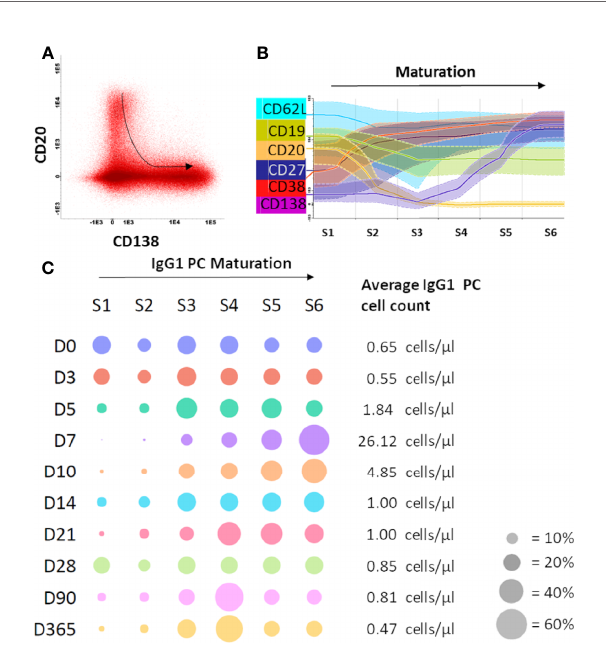
FIGURE 4 | Maturation of IgG1 plasma cells was observed upon immunization with aP booster. (A) Flow cytometry fi les containing the plasma cells of all donors at all time points were merged in the In fi nicyt software to visualize plasma cell maturation. The plasma cell maturation, de fi ned by downregulation of CD20 and upregulation of CD138, is shown in the dot plot. The arrow indicates the direction of the maturation pathway. (B) Based on this CD20-CD138 maturation pathway, the In fi nicyt software maturation tool identi fi ed 4 additional markers in the fl ow cytometry panel that were up- or downregulated upon plasma cell maturation. Based on the 6 identi fi ed markers (CD19, CD20, CD27, CD62L, CD38, CD138), 6 maturation stages were de fi ned. (C) Per time point the percentage of plasma cells in each maturation stage was plotted (total IgG1 plasma cells of all donors, grouped per time point). The size of the dot indicates the percentage of plasma cells in a given maturation stage (average of 10 donors). Cell count is shown at the right side of the plot (average of 10 donors). The bubble plot was generated using plotly python graphing library. D, Days after